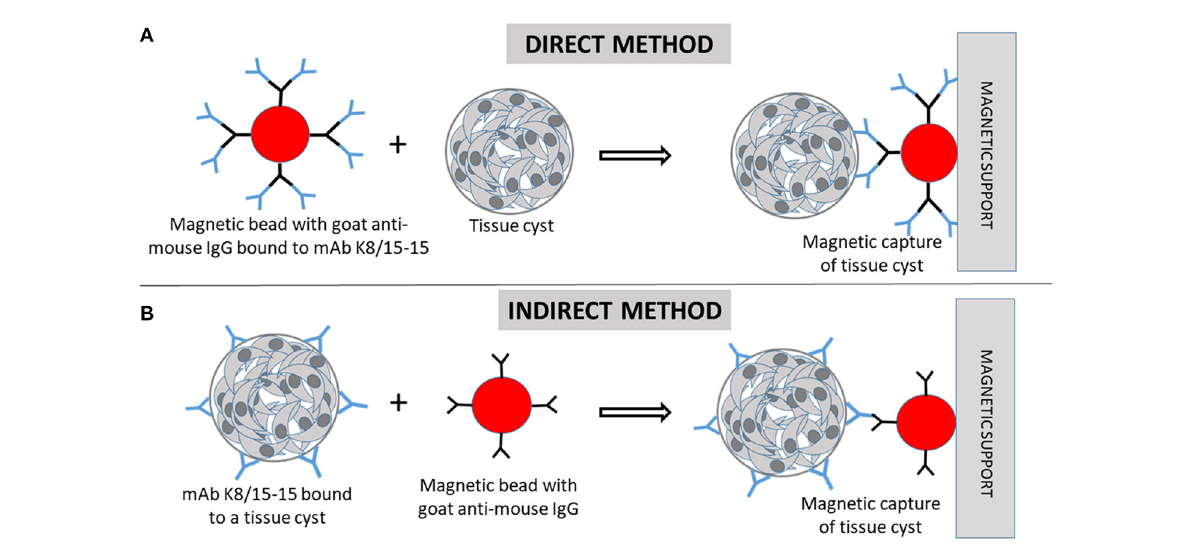
FIGURE1 Immunomagnetic separation of Toxoplasma gondii tissue cysts (TC). (A) In the direct capture, magnetic beads coated with goat anti-mouse IgG are firstly incubated with the monoclonal antibody (mAb) K8/15-15. Then, the cell suspension containing TC are incubated with the beads. (B) In the indirect method, the cell suspension containing tissue cysts are firstly incubated with the mAb, followed by incubation with the magnetic beads. (A,B) The beads bound to TC are magnetically captured by the magnetic support (magnetic cell separator).